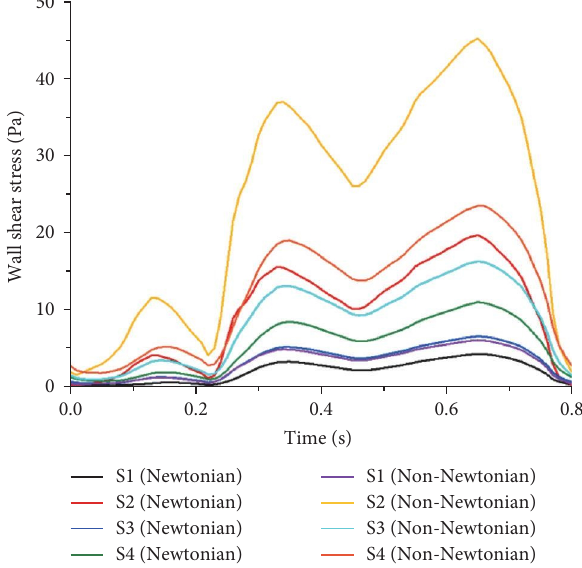
F IGURE 10: Maximum wall shear stresses on normal branches.